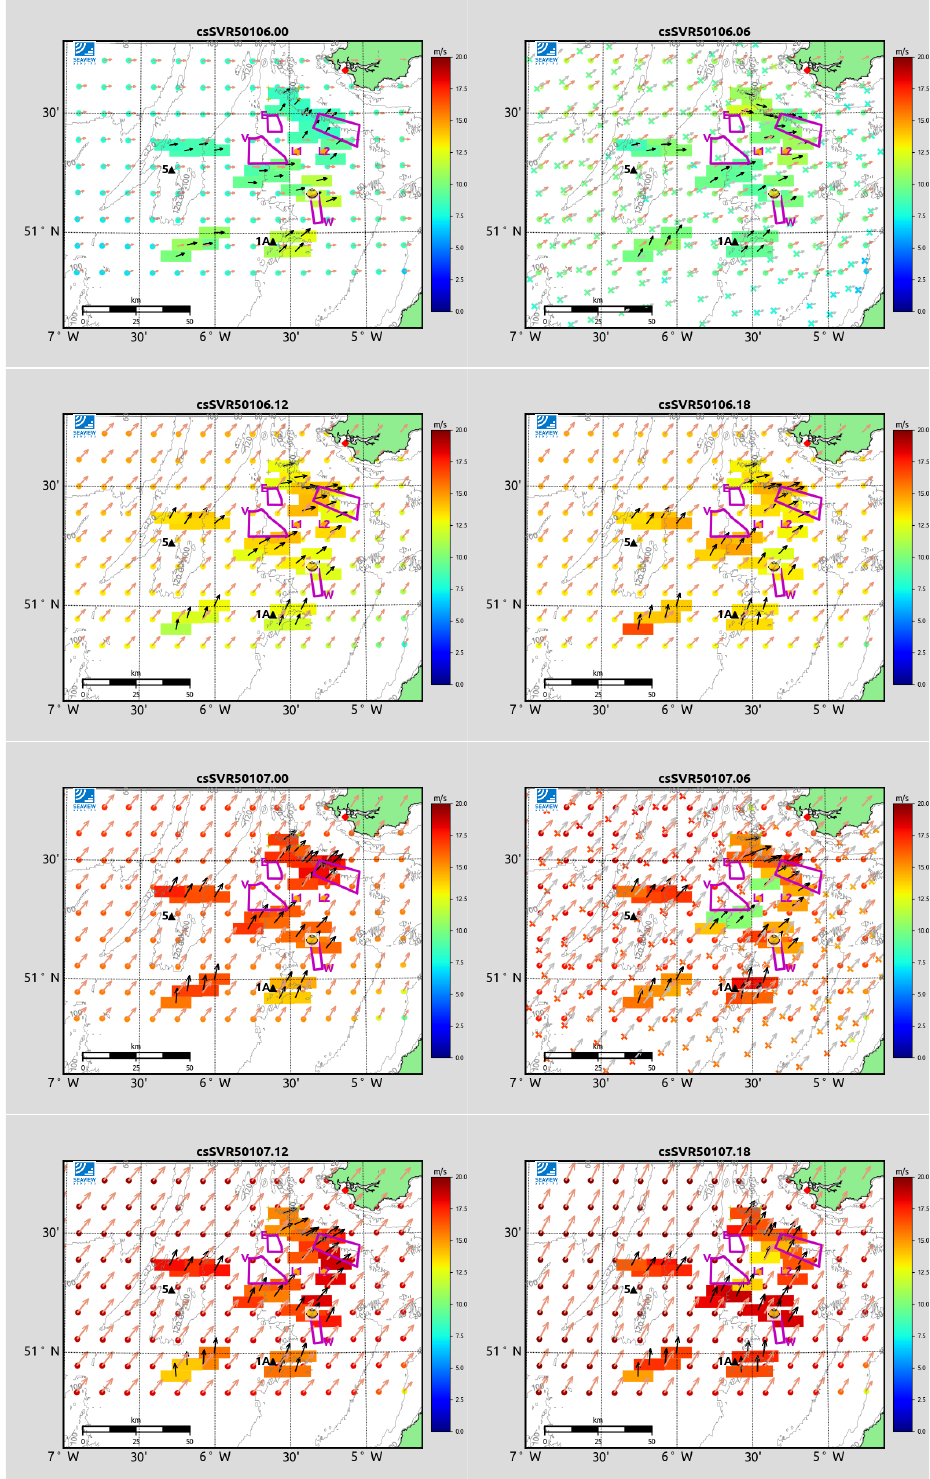
Figure 7. Maps of wind speed and direction for NCS every 6 h from 12:00 a.m. on 6 January 2005 (top left) to 6:00 p.m. on 7 January 2005 (bottom right). Speeds are colour-coded as shown on the scale. Large rectangles are radar cells, Met Office wind model and Quickscat are marked with circles and x , respectively. Black, brown, and grey arrows are radar, model and QuikSCAT directions, respectively. The magenta regions mark positions of potential offshore floating wind sites. The small buoy image marks the position of a directional waverider during the trial